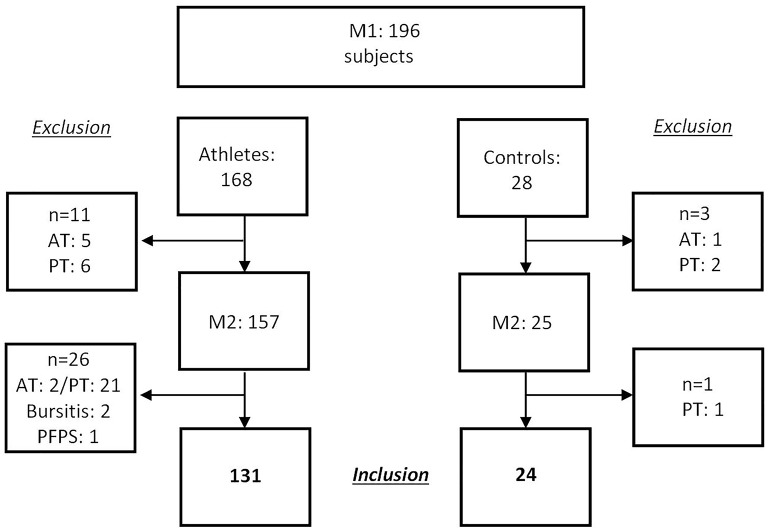
Study flow chart: recruitment at M1, exclusion of subjects due to diagnoses (Atp, Achilles tendinopathy; Ptp, patellar tendinopathy; PFPS, patellofemoral pain syndrome) in the region of Achilles and patellar tendons.